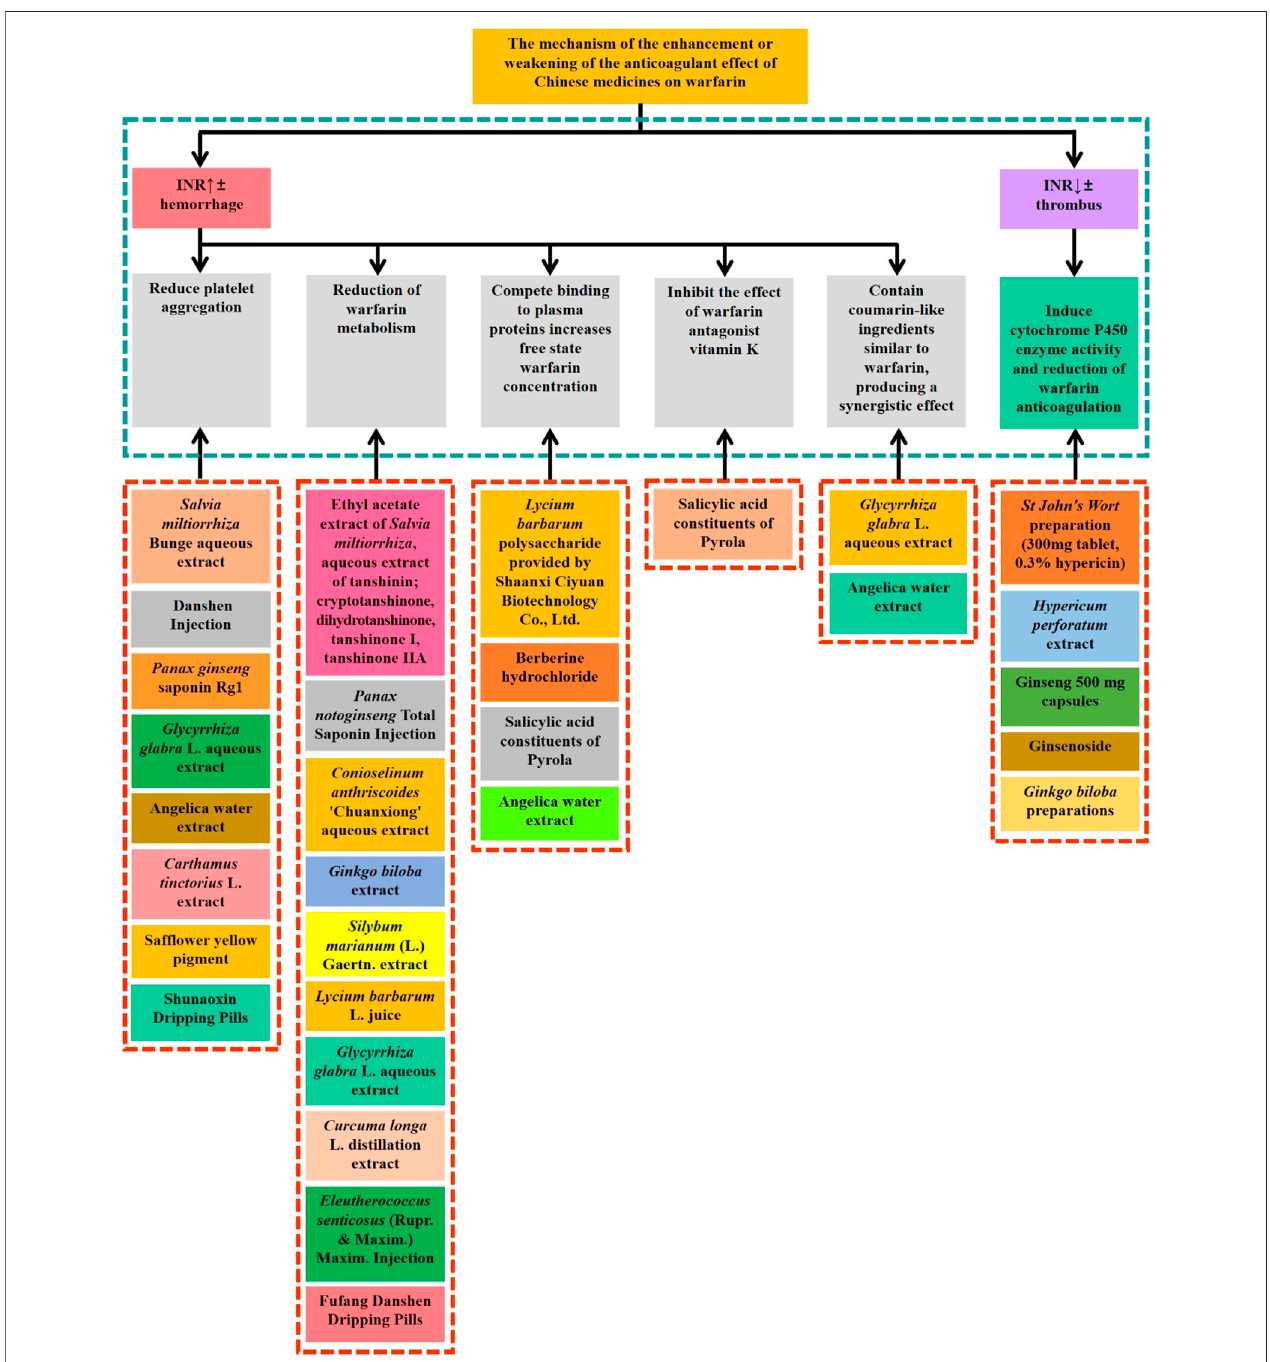
FIGURE 1 | Chinese medicines (single Chinese medicine, Chinese medicine extract, Chinese patent medicine or compound medicine) that have in fl uence on warfarin and their action mechanism.